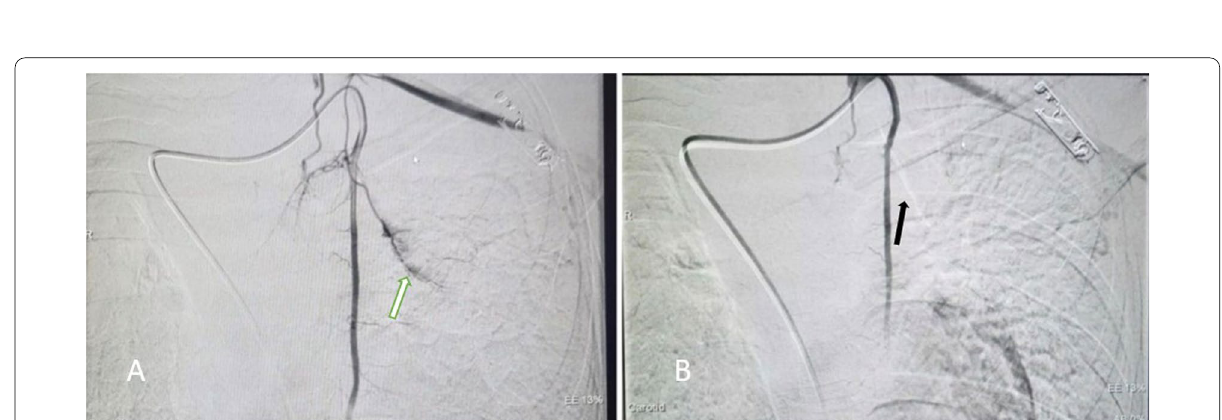
Fig. 3 A Digital subtraction angiography (DSA) image after super-selective catheterization of the left internal mammary artery shows contrast blush representing collateral channels supplying the bronchial circulation (white arrow). B Post-embolization after PVA particles, the DSA images show complete absence of contrast blush (black